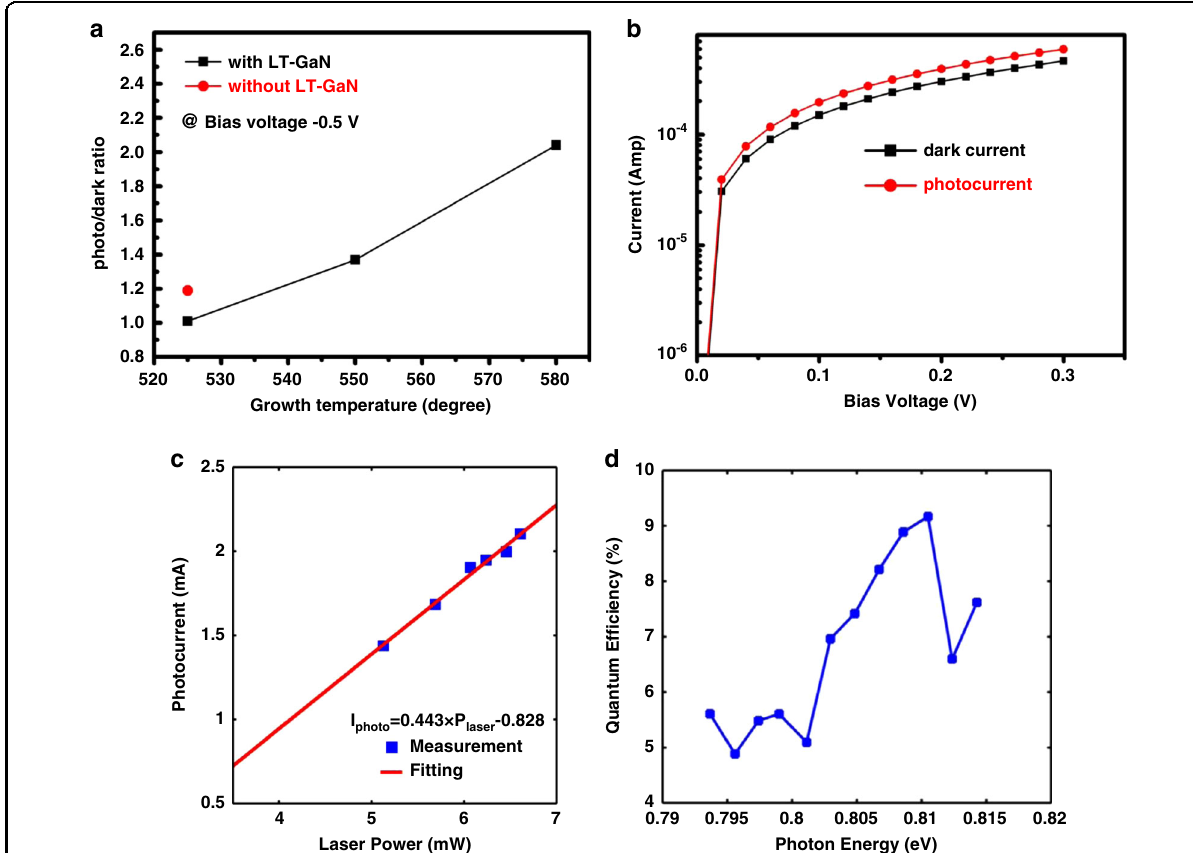
Fig. 9 Photodetector behavior for InN QD-based Schottky photodiode. a Photocurrent to dark current ratio at varied InN growth temperatures, uncapped and capped. b Reverse bias I – V characteristics, with InN QDs grown at 525 C, with and without 1550 nm laser illumination. c Difference in photocurrent and dark current at − 0.2 V, at varied laser powers. d External quantum ef fi ciency versus photon energy. Reprinted with permission from 82 © The Optical